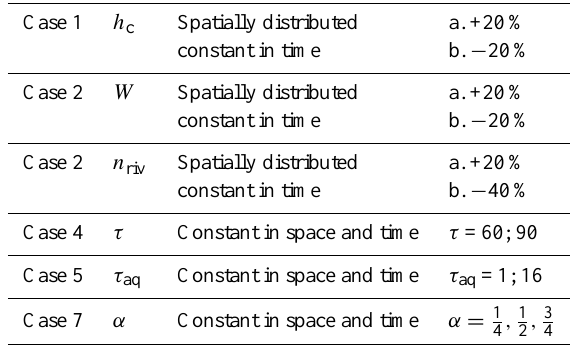
Table 7. ISBA/TRIP key input parameters and the variations ap- plied for sensitivity